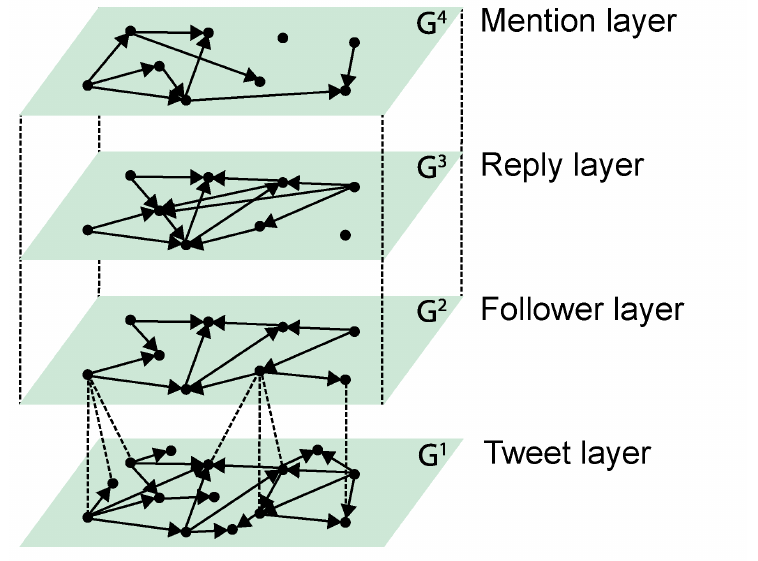
Figure 1. Twitter represented via multilayer network. Communication on Twitter captured via four layers of multilayer network: G 1 , tweet layer; G 2 , follower layer; G 3 , reply layer; and G 4 , mention layer. The interconnections between nodes of the tweet layer and the follower layer are established if the user (node) from G 2 posts a tweet (node) from G 1 . Other interlayer links are not represented in this figure due to the better visibility; however, G 2 , G 3 and G 4 are connected as multiplex network as explained in the text